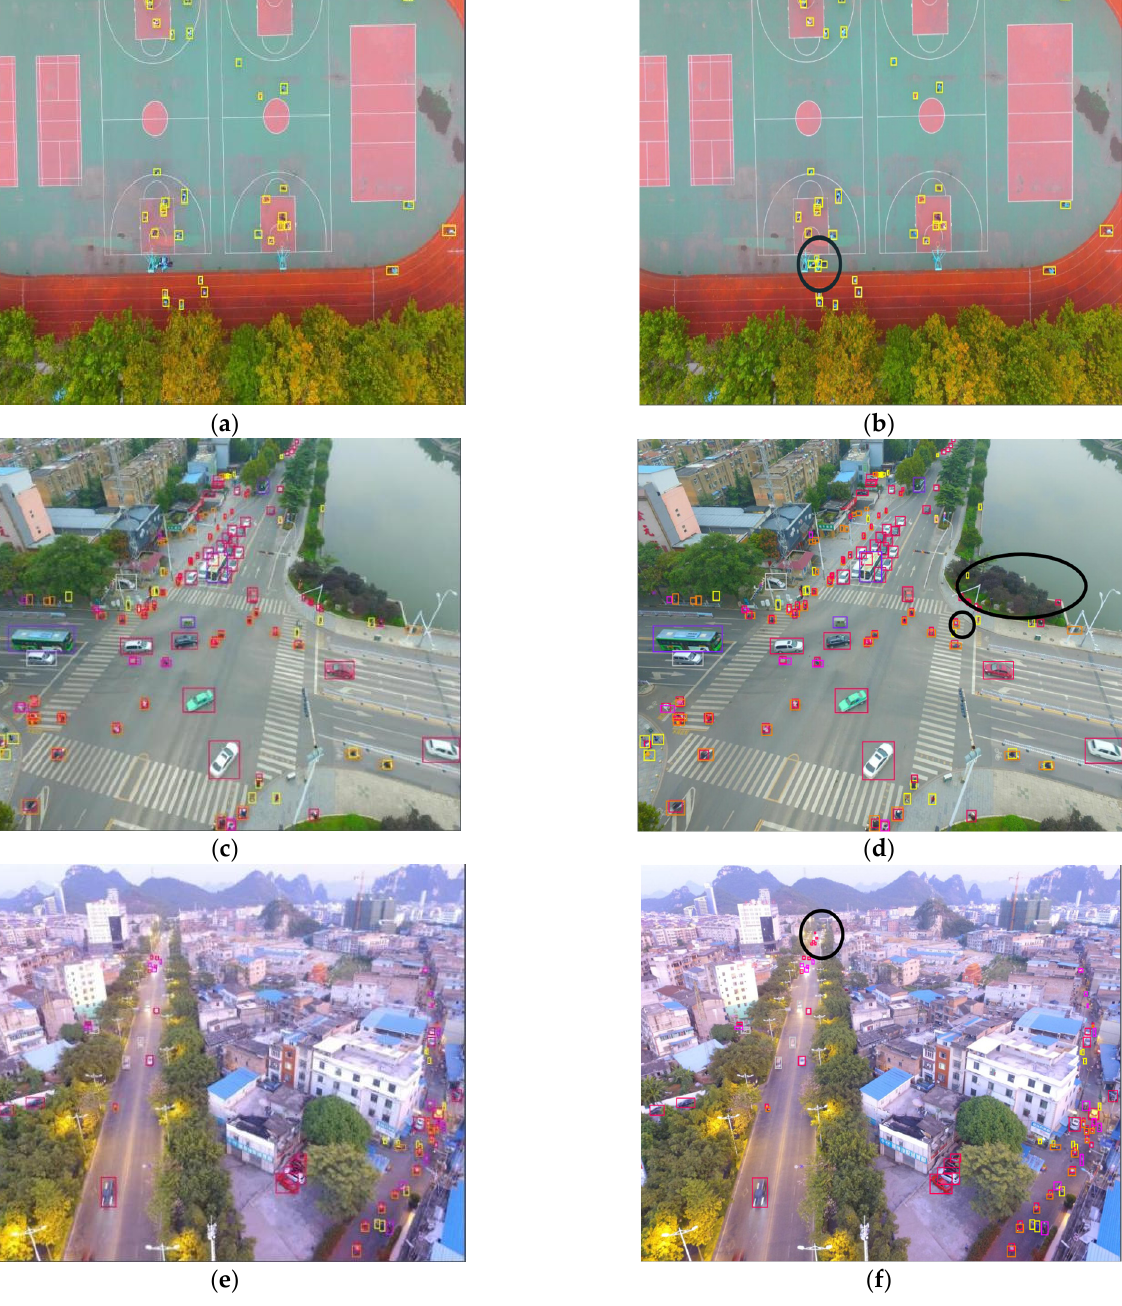
Figure 5. Visual comparison of detection effect between the FCOS algorithm and the improved algorithm in this paper. ( a , c , e ) are the detection results of FCOS ; ( b , d , f ) are the detection results of the algorithm in this paper.